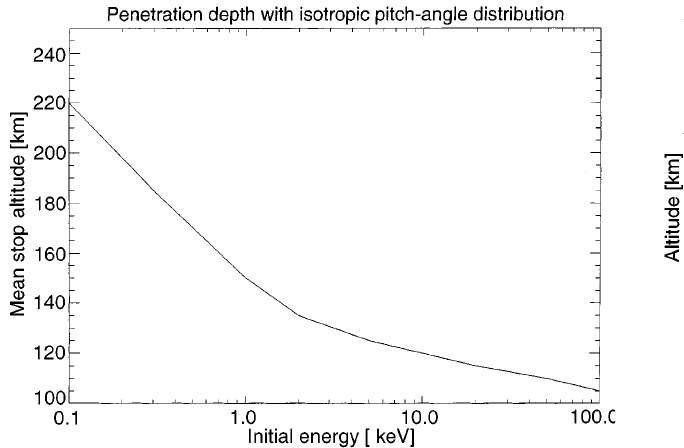
Fig. 3. Penetration depth of auroral proton/hydrogen particles